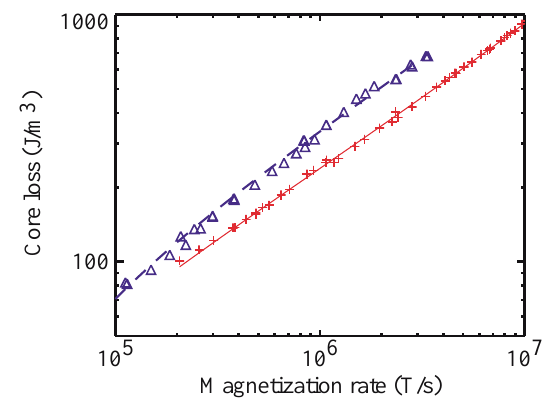
FIG. 12. (Color) Core loss versus magnetization rate for a MET- GLAS 2605 SA1 core, manufactured by NAM, insulated with a magnesium methylate coating and annealed. The data are for the listed flux swings: ( 1 , red, solid line) at 2.70 T; ( (cid:3) , blue, dashed line) at 2.50 T; and ( (cid:1) , green, heavy line) at 2.20